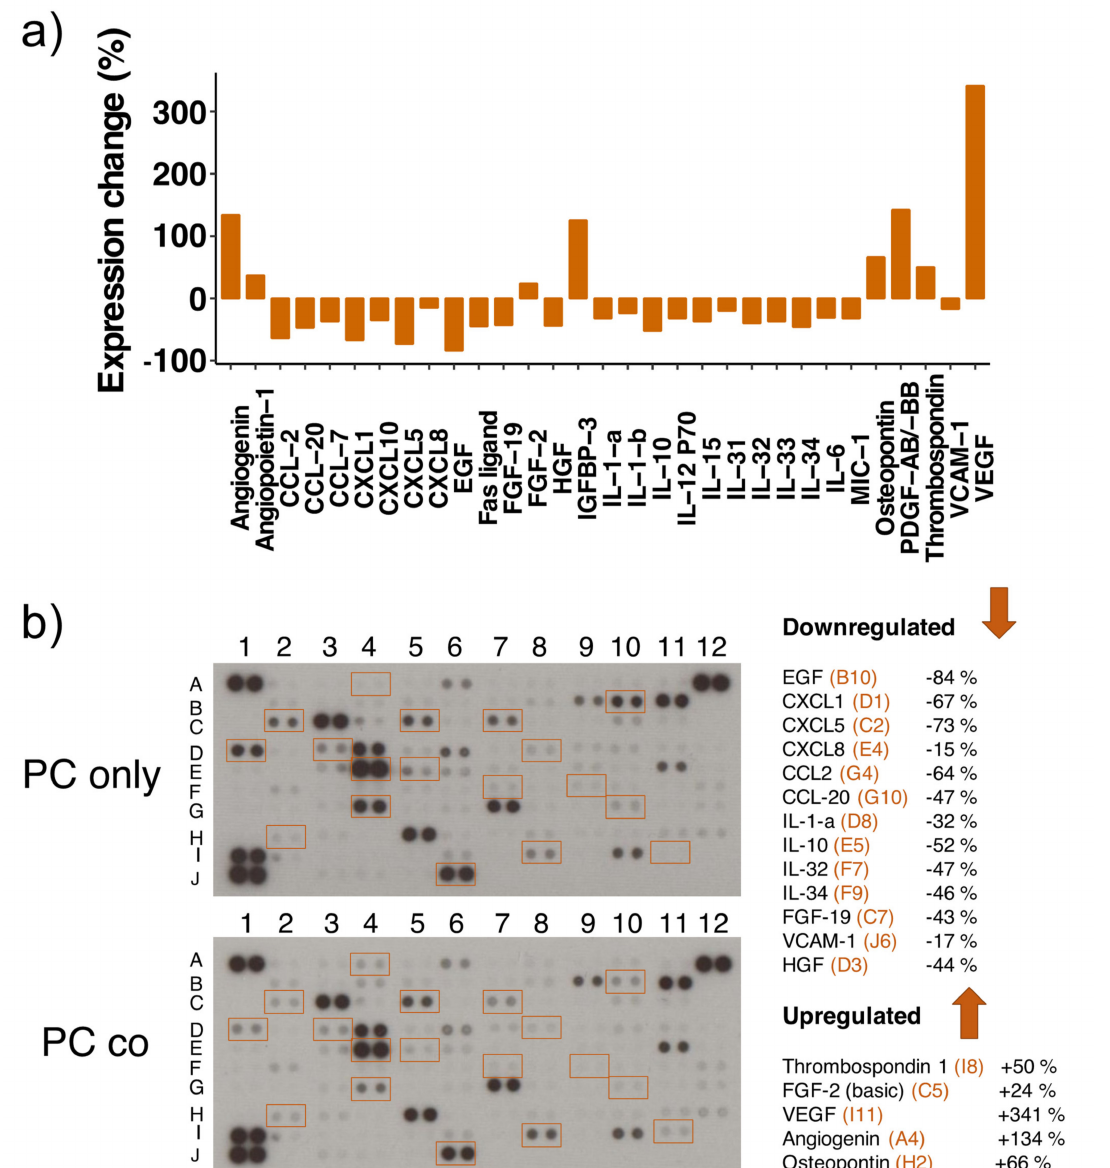
Figure 5. Differential expression of several cytokines in mono- and co-cultured pericytes (PCs). Cytokine proteome analysis has been performed with the Proteome Profiler Human XL Cytokine Array Kit using equal amounts of cell lysates from PCs cultured alone (PC only) and in co-cultures with endothelial cells (PC co). Experiments were performed twice with independently prepared samples. The bar graph shows the changes in protein expression levels in % between co- and mono-cultured PCs (positive values: increased expression in co-culture, negative values: decreased expression in co-culture) ( a ). Included are results from 5- and 10 min array blot exposure and only proteins regulated accordingly in both experiments are shown in the bar graph. Representative array blots are shown after an exposure time of 5 min ( b ). Array blots from both experiments and exposure times are shown in Supplementary Figure S3. The legends on the right of the array blots denote the regulated proteins together with the coordinates for their location on the blots in